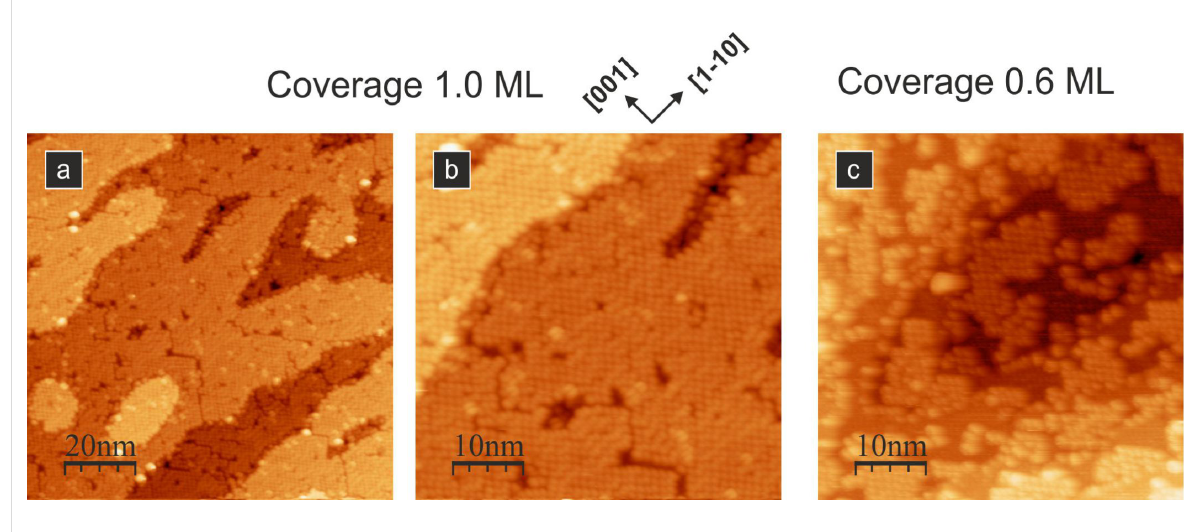
Figure 2: Empty-state STM images of the densely packed molecular structures. (a) and (b): the closed layer PTCDA structure obtained when the mol- ecules are adsorbed on a sample kept at elevated to 100 °C temperature; (c) 0.6 ML of PTCDA molecules adsorbed on the sample kept at 100 °C. All STM images were acquired with a 2 pA tunnelling current and a 2.0 V bias voltage. The figure has been adapted from